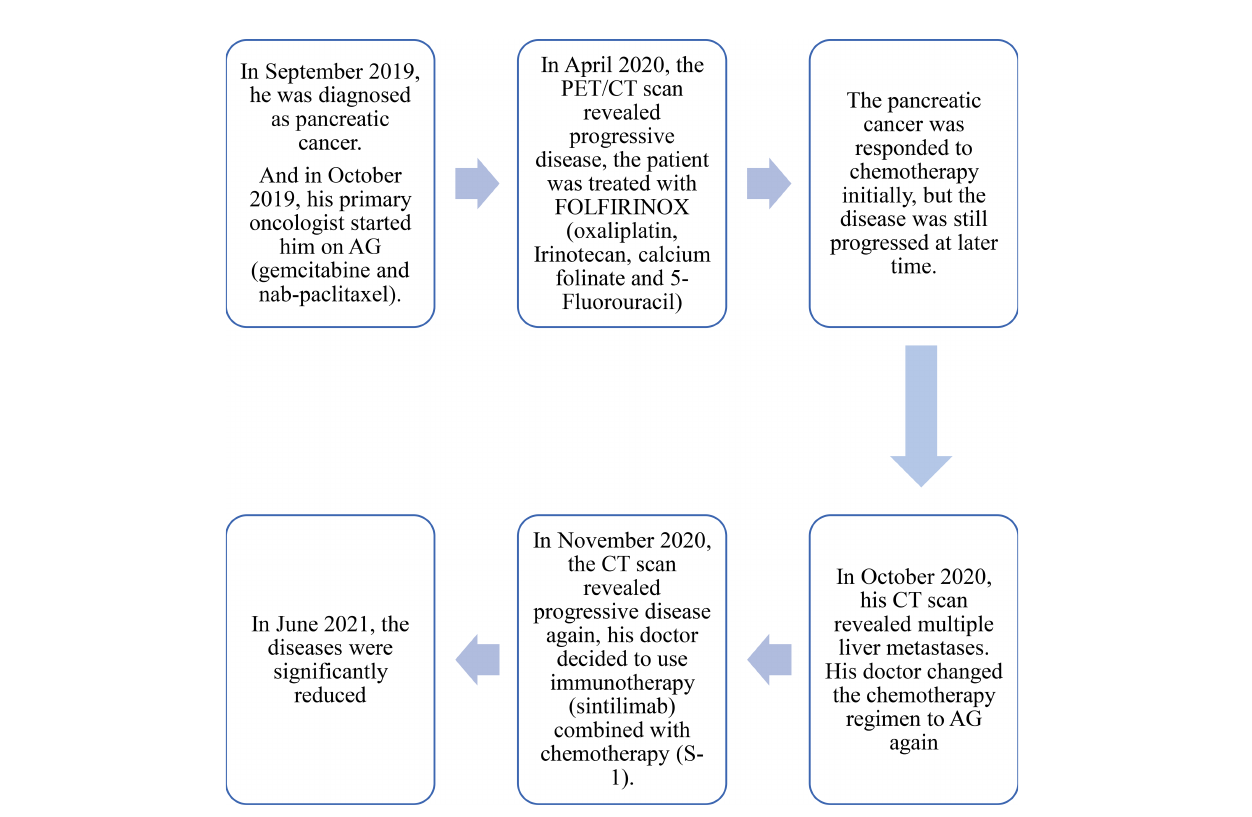
FIGURE 3 | Timeline of the treament. The patient was diagnosed with pancreatic cancer in September 2019, and received chemotherapy (AG) in October 2019. Before receiving immunotherapy in November 2020, the patient had undergone multi-line chemotherapy (including AG, FOLFIRINOX, AG). And until August 2021 (the latest follow-up), the patient was still receiving immunotherapy combined with